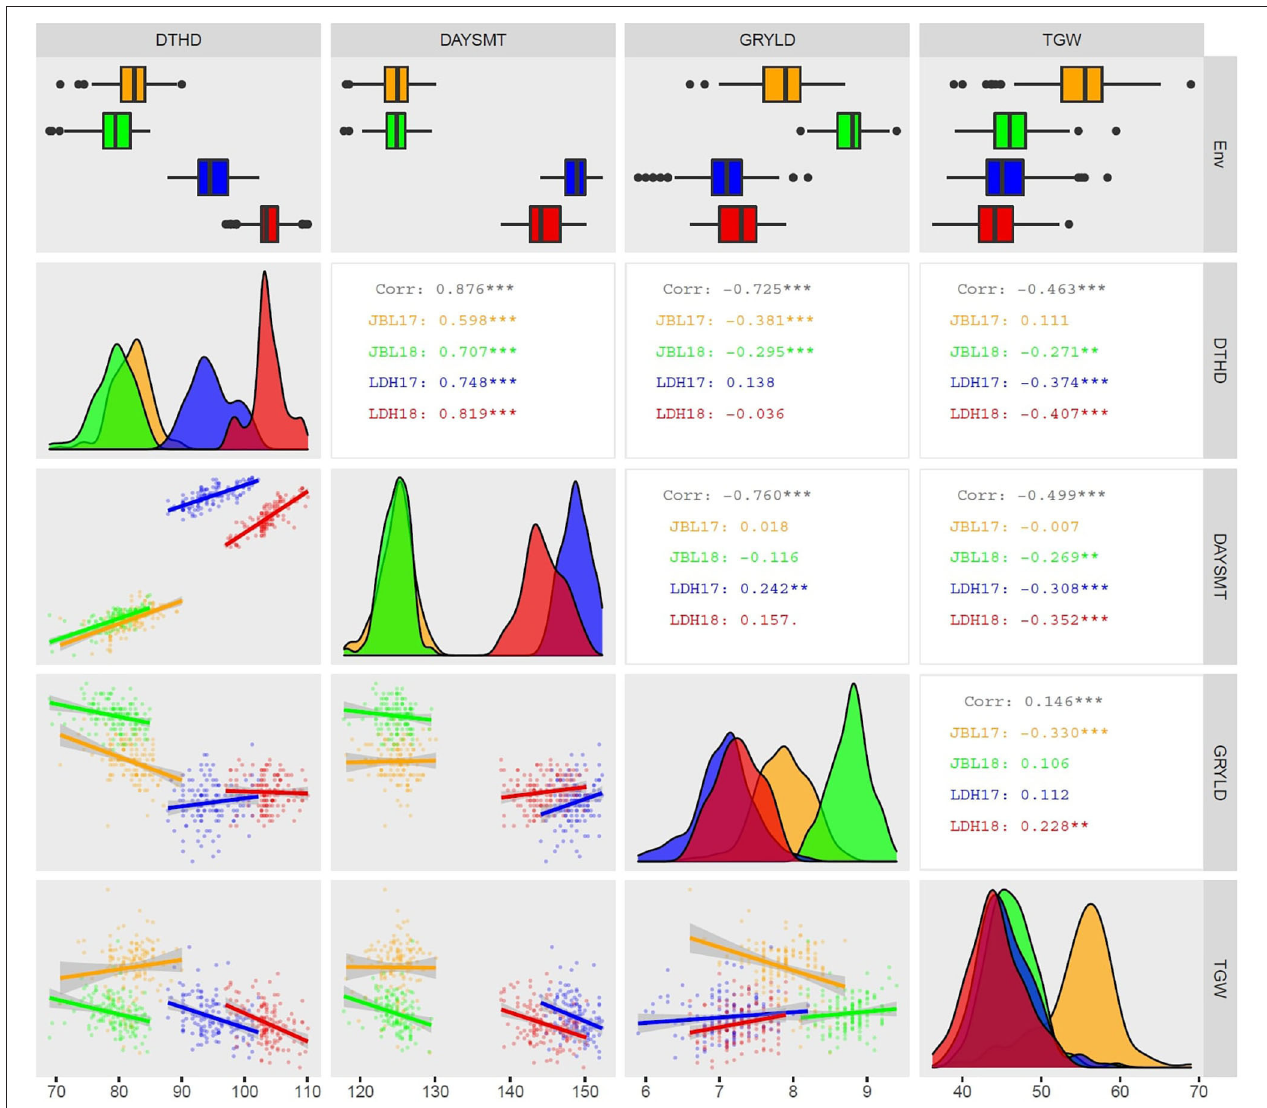
FIGURE 4 | Distributions, scatter plots, and correlations between agronomic traits using best linear unbiased predictions from combining and four experiments [Ludhiana (LDH)17, LDH18, Jabalpur (JBL)17, and JBL18]. The distribution of DTHD, DAYSMT, GRYLD, and TGW values is displayed on the diagonal with environments indicated by colors. The top row represents the distribution of traits as boxplots. The upper right triangle shows pairwise correlation values as overall correlation in black color while other colors are represented individually as explained earlier. The correlations among environments are displayed as scatter plots in the lower triangular area and as the Pearson’s correlation coefficients in the upper triangular area. Numbers indicate a correlation that is significantly different from 0 at an alpha level of 0.05. DTHD, DAYSM, GRYLD, and TGW. ## level of significance; *** p < 0.001, ** p < 0.01, * p < 0.1, and p